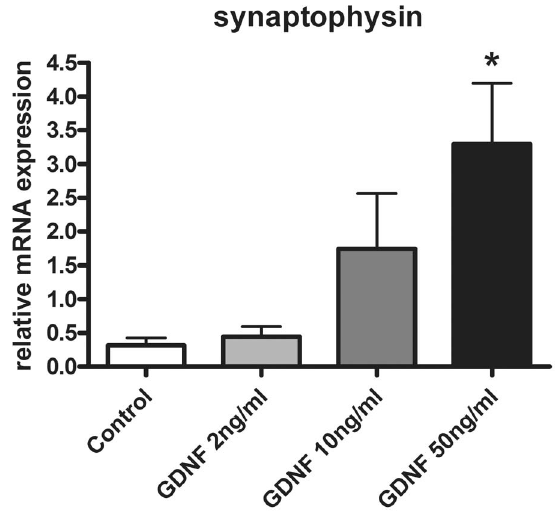
Figure 5. Synaptophysin mRNA expression of enteric nerve cell cultures after GDNF treatment. GDNF increases mRNA expression of synaptophysin in rat enteric nerve cell cultures. Expression levels were measured after one week and are normalized to expression of the house-keeping gene HPRT. Data are shown as mean + / 2 SEM, n=11– 12 per experimental group, *p , 0.05 vs. control.